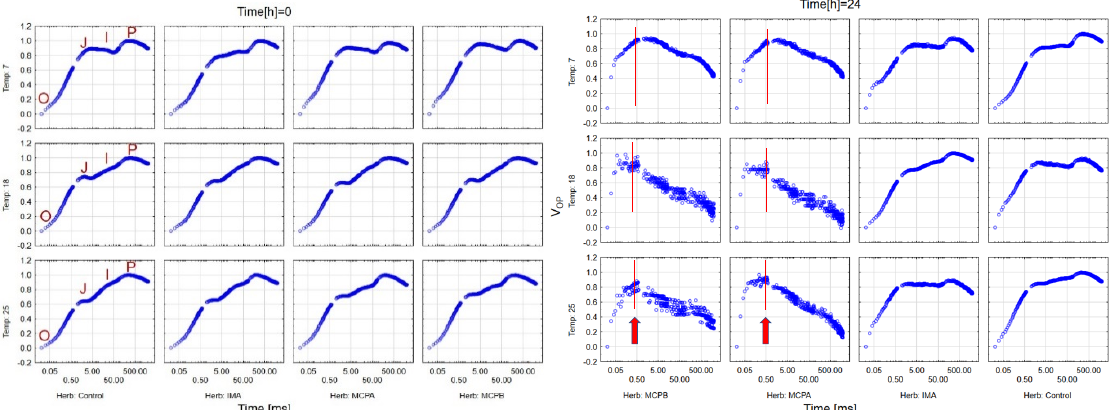
Figure 8. Normalized expression of fast chlorophyll fluorescence kinetics (OJIP, V OP ) recorded before the application of herbicides ( left panel ) in the plants exposed for 24 h to MCPA, MCPB and IMA ( right panel ). The arrows indicate an increase of chlorophyll fluorescence in point J (relative to point P) in MCPA- and MCPB-exposed plants. Data are presented for the G. orientalis cultivated at three different temperatures (7, 18 and 25 °C in the upper, middle and lower rows).